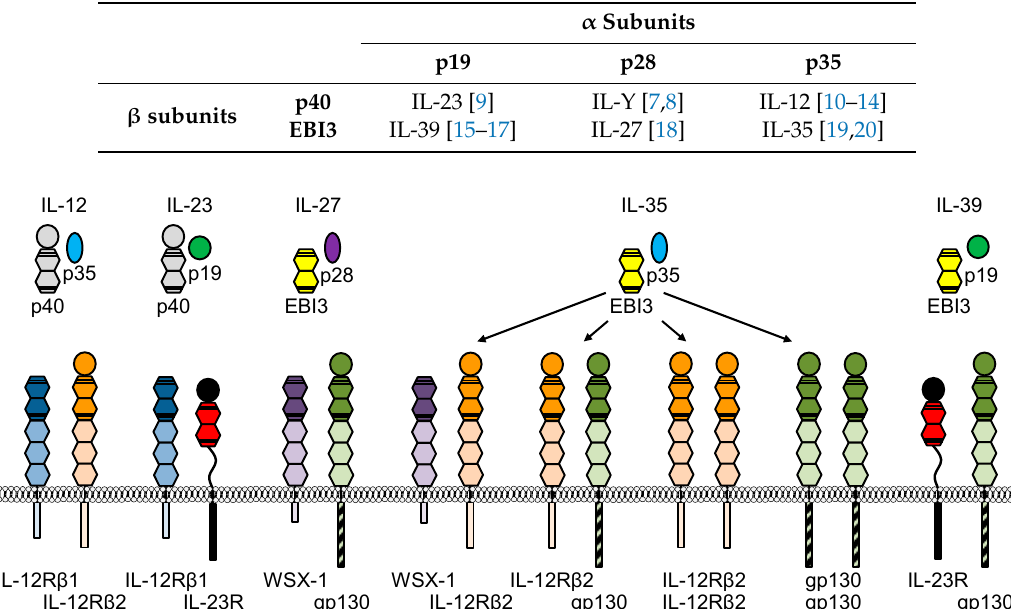
Table 1. IL-12 Cytokine Family Members.